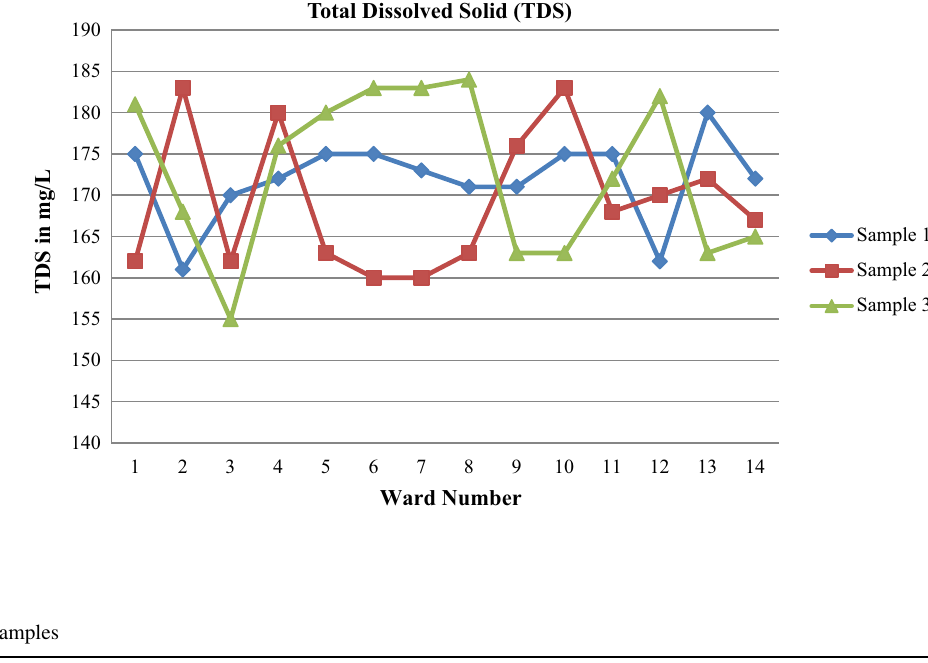
Table 3 Inclusive results of water samples Ward